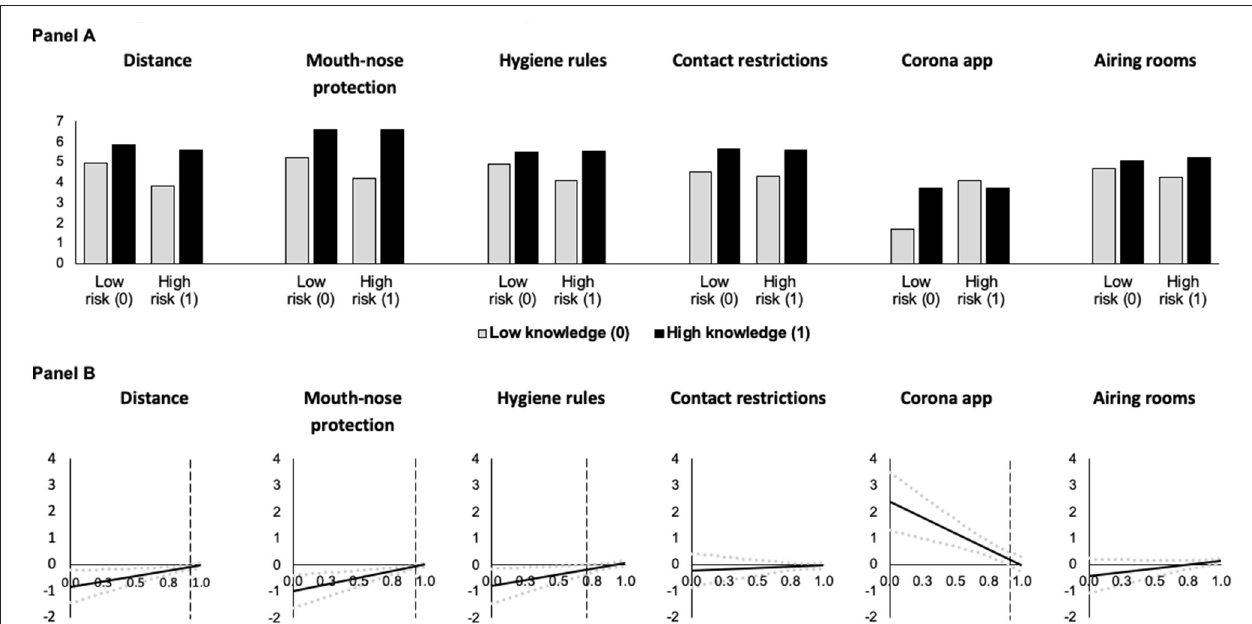
FIGURE 3 | Predicted adherence as a function of risk of exposure at different levels of knowledge about COVID-19 (A) and conditional effect of risk of exposure as a function of knowledge about COVID-19 (B) (based on Models 3 and 8 in Tables 4 , 5 , N = 4,096). In (A) , predictions are for men who are 18 years old who have medium levels of threat. In (B) , the black solid lines ( — ) indicate the conditional effect of risk group membership from the lowest (0) to the highest (1) level of knowledge about COVID-19 and dotted gray lines ( • • • ) indicate the upper and lower 95% confidence interval. Vertical dashed black lines indicate the Johnson-Neyman value of knowledge above which the effect of risk group membership becomes statistically insignificant ( p > 0.05). For the contact restrictions and airing rooms models, the effect is statistically insignificant throughout.